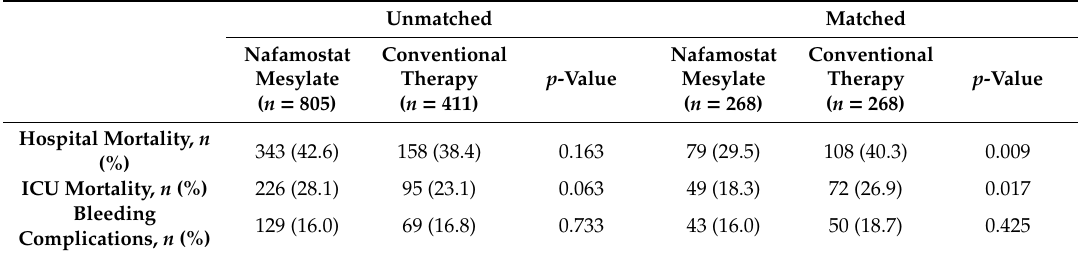
Table 3. Outcomes in the nafamostat mesylate and conventional therapy